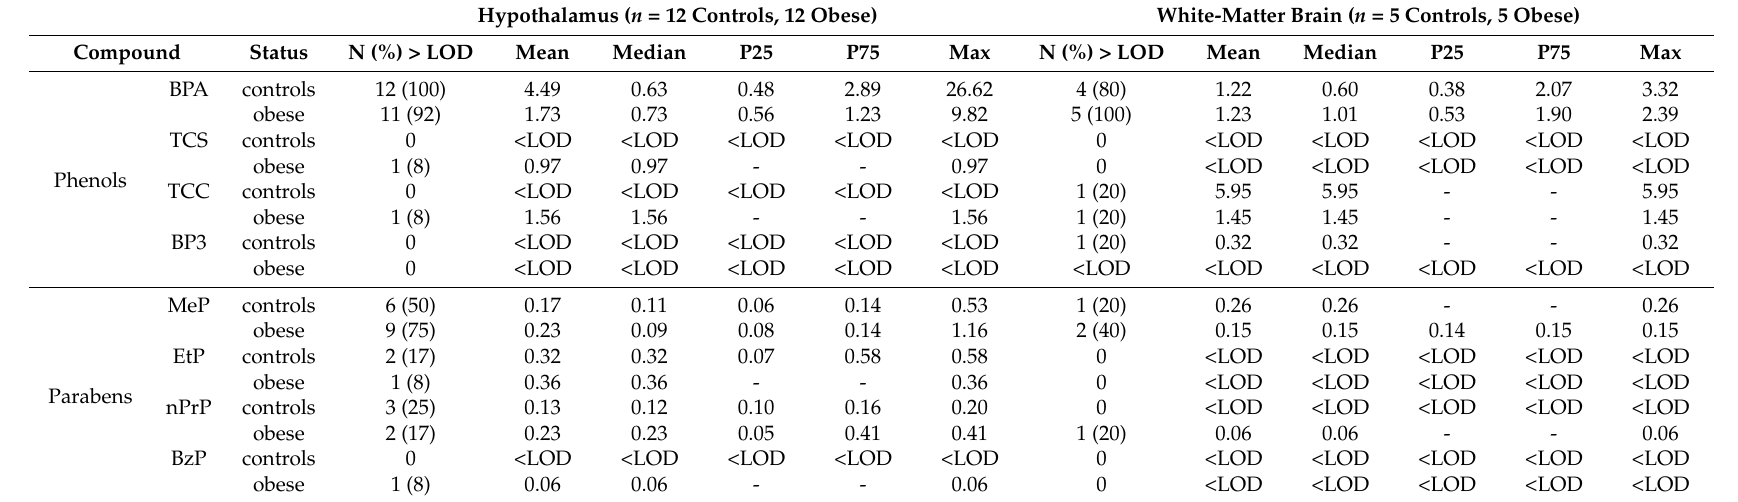
Table 2. Descriptive analysis of detected npEDC (ng/g) in hypothalamus and white-matter brain tissue by obesity